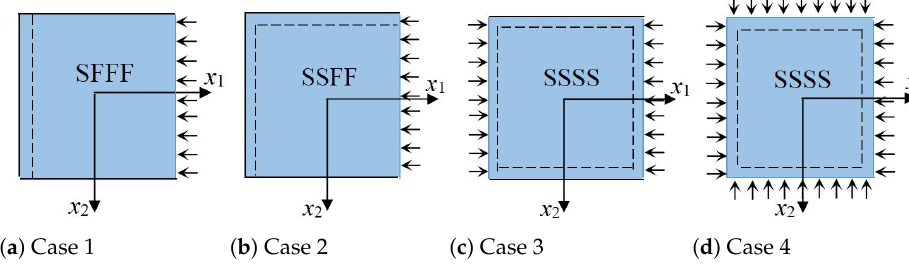
listed in Table 3. The combinations of boundary and load conditions included SFFF/uniaxial